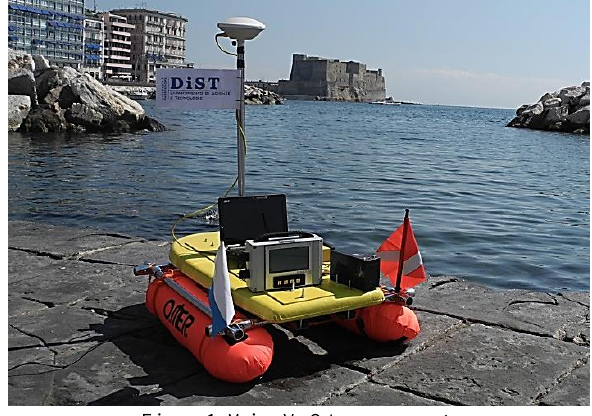
Figure 1. MicroVeGA components Airborne LiDAR bathymetry emits a short pulse, consisting of infrared and green lasers, to the water’s surface. The infrared pulse is scattered across the water’s surface; the green one penetrates the water columns, is attenuated in dependence on water clarity (maximum attenuation: 70 m) and then it is scattered across the bottom of the water column. A receiver on the aircraft measures the scattered pulses and the passed